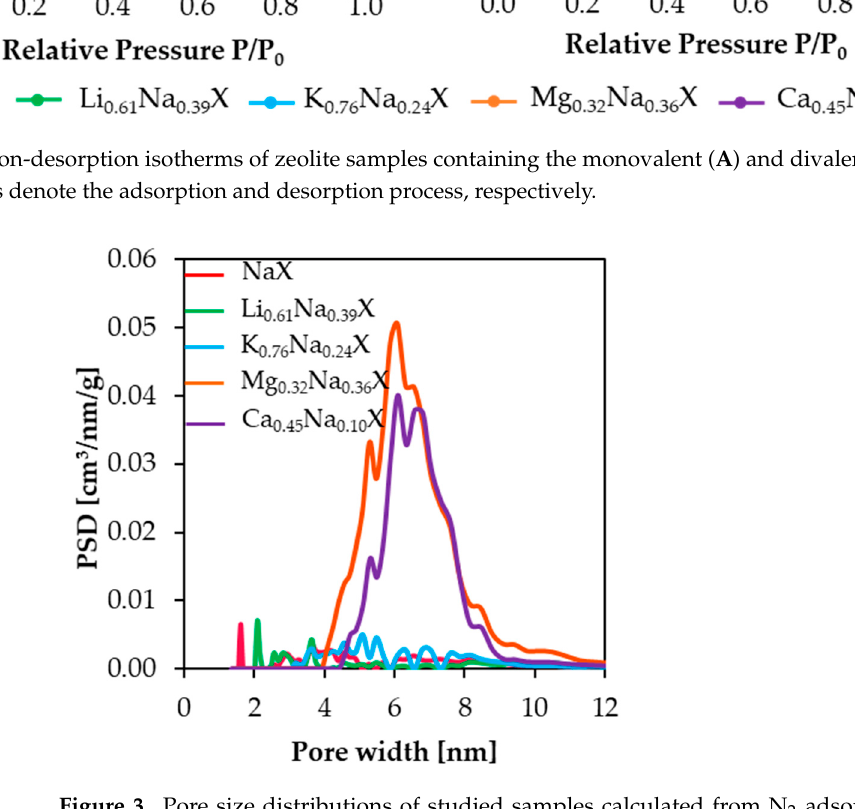
Figure 3. Pore size distributions of studied samples calculated from N 2 adsorption/desorption iso- therms at 77 K. isotherms at 77 K. Table 2. Textural properties of the investigated